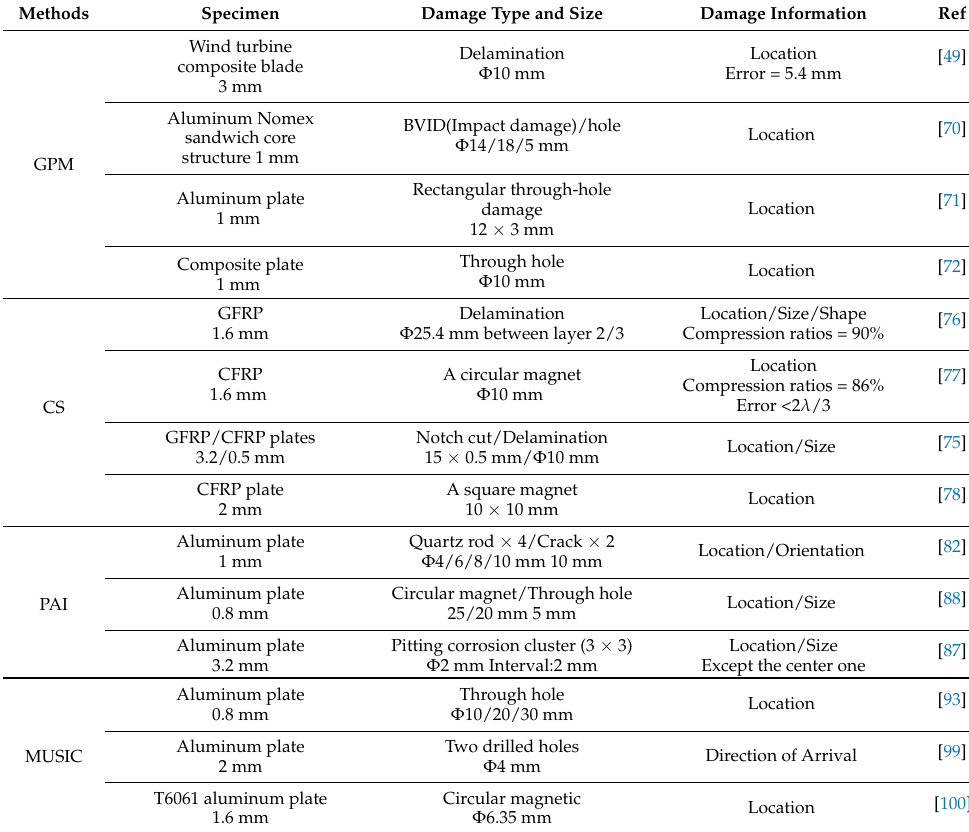
Table 3. Related literature and detection results of detection methods based on a small amount of wavefield